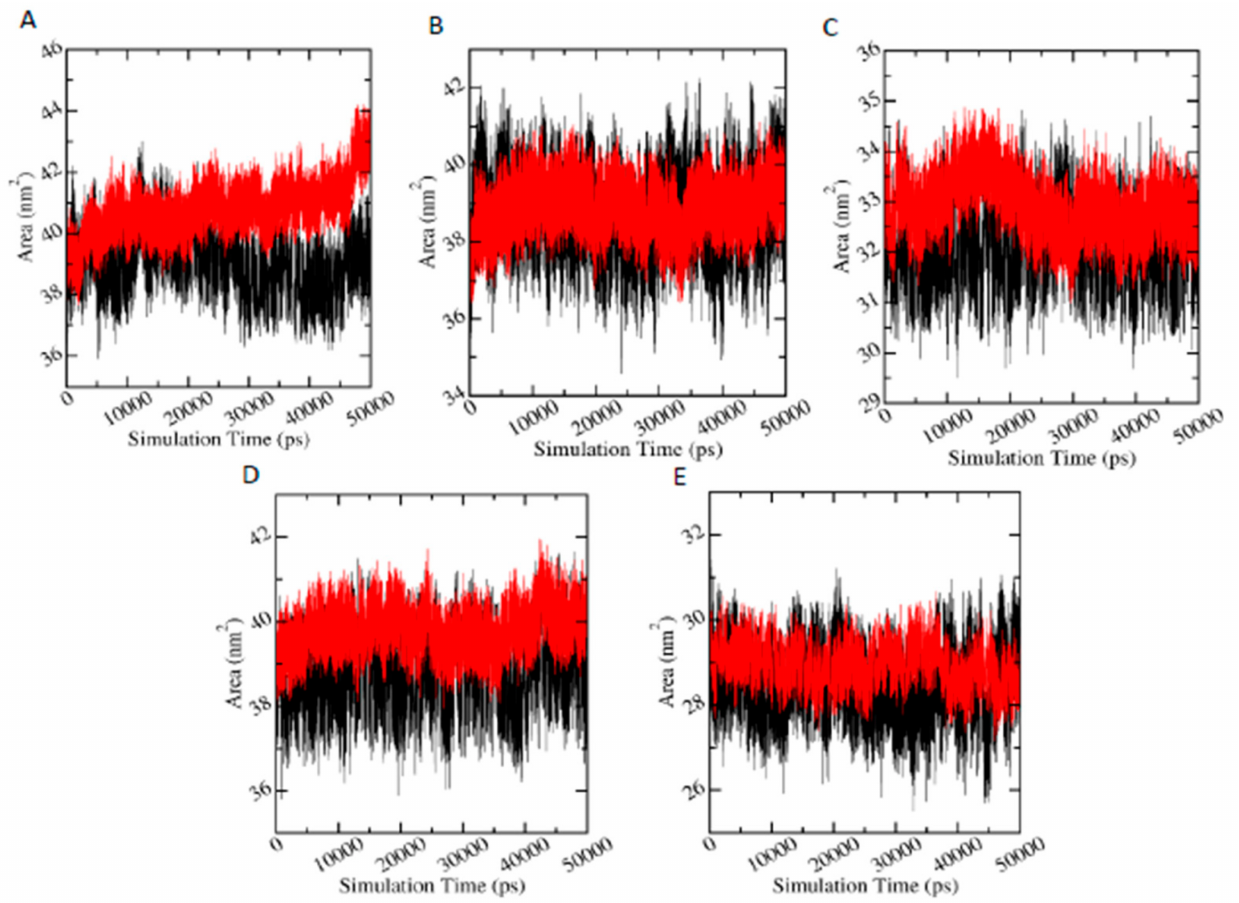
Figure 7. Plot solvent accessible surface area (SASA) (nm 2 ) versus simulation time (pS), where black and red color plots represent the parent pesticide and metabolite, respectively. A , B , C , D , and E indicate AChE-FM/FMS, AMPK-FN/FNS, ASK1-FM/FMS, GST-IM/6-CIPHD, and PKC-IM/6-CIPHD complexes,